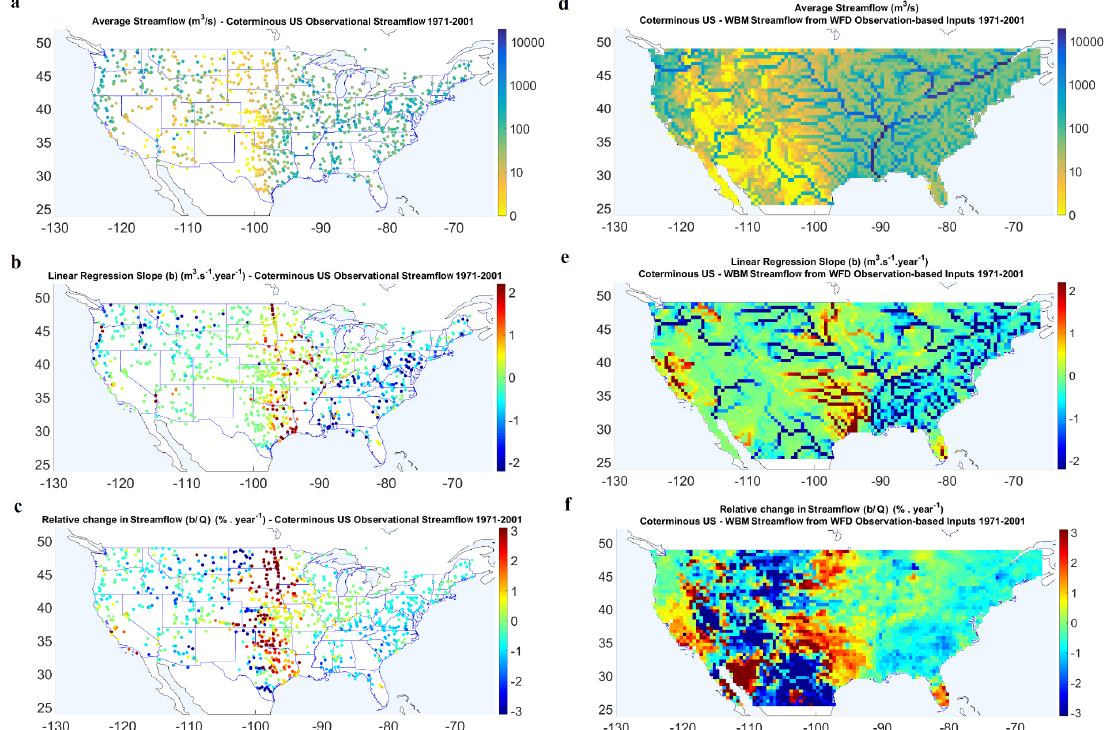
Figure 1. WBM model versus observations streamflow data 1971–2001 maps for Coterminous US—Log of annual-averaged daily streamflow map for observations ( a ) and WBM model ( d ), Slope of change in streamflow map for observations ( b ) and WBM model ( e ) and relative change in annual-averaged daily streamflow map for observations ( c ) and WBM model ( f ). Lower axis of the maps represents the latitude and left side axis represents the longitude of the girds. Table 1. Statistics of variation of streamflow trend results for observations, as well as WBM simulations in the Coterminous United States from 1971 to 2001. The observational discharge is station measurements; whereas the WBM simulated discharge average is per grid cell. WBM results are for all grid cells of the Coterminous US, as shown in Figure 1d. Ave. = Average, Min. = Minimum, Max. = Maximum, Med. = Median, St. Dev. = Standard